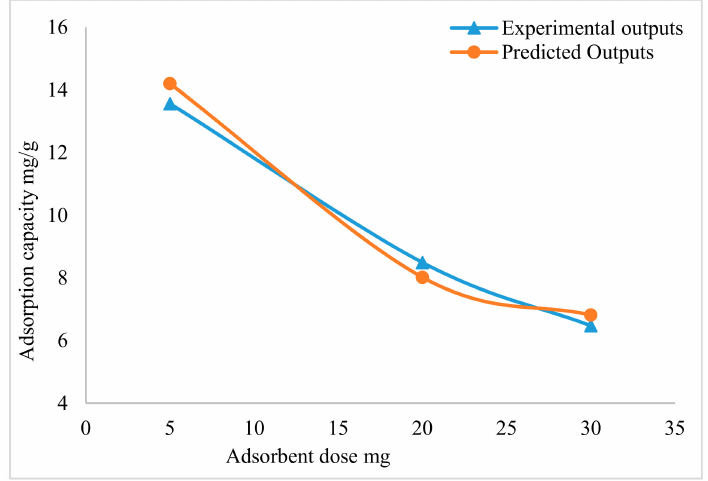
Figure 3. E ff ect of adsorbent